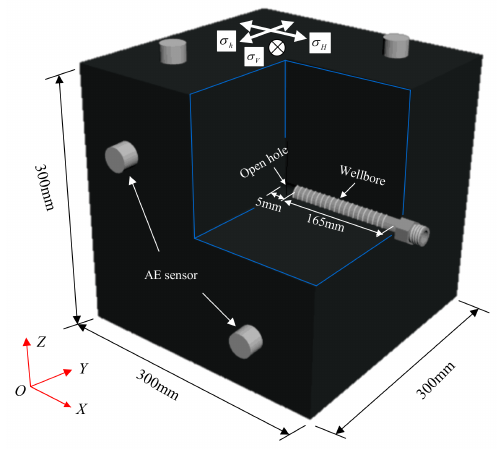
Figure 18. Diagram of the testing